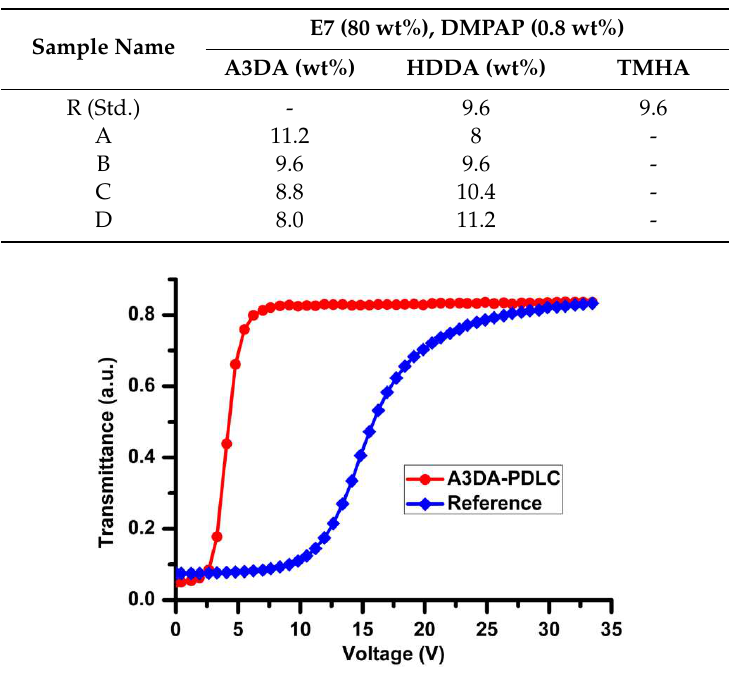
Figure 2. Transmittance dependence on the applied electric field for A3DA-PDLC (sample B) and reference cell (sample R) measured at 303 K, λ = 633 nm.